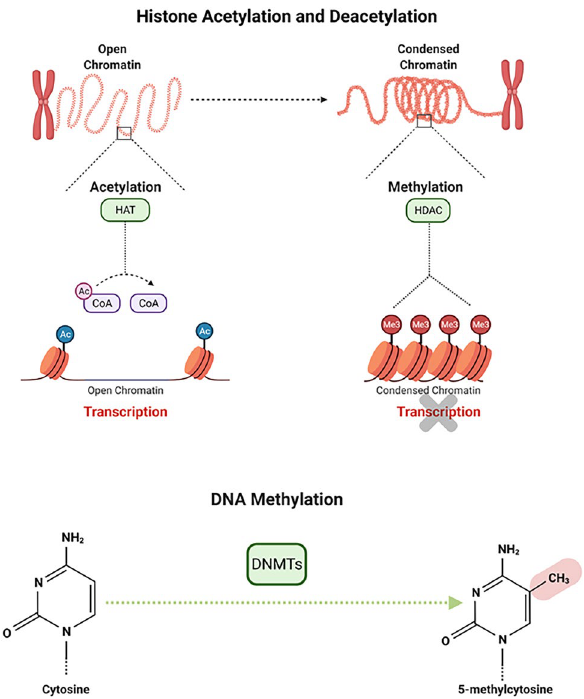
Figure 1. Histone acetylation and deacetylation through HAT and HDAC enzymes